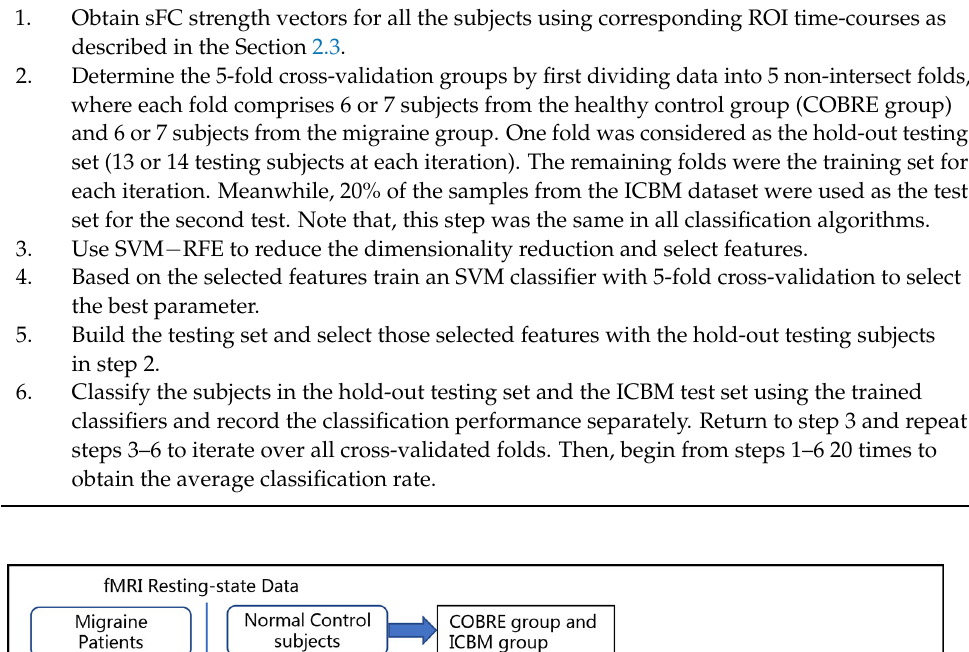
Algorithm 1 : classification based on sFC strength features